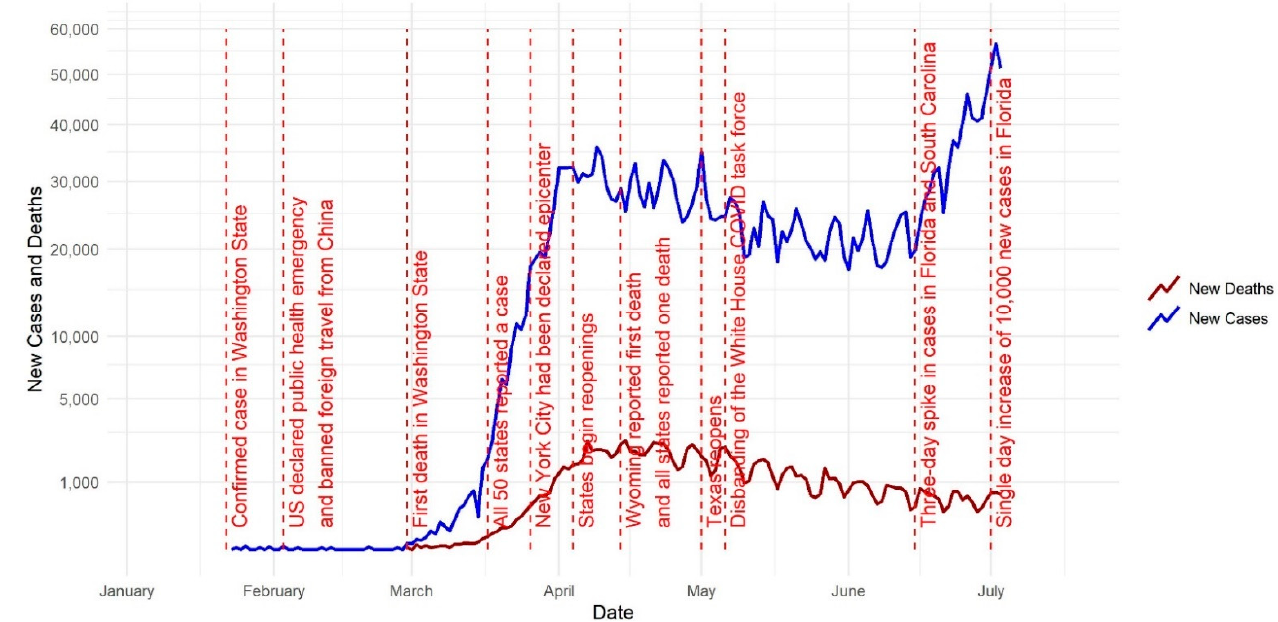
Figure 1. New COVID-19 cases and deaths in conjunction with the timeline of COVID-19 developments.